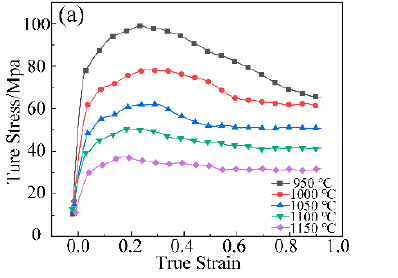
Figure 2. True stress-strain curves under different deformation conditions, i.e., ( a ) 0.01 . 0.1 ε= and ( c ) 1 ε= .